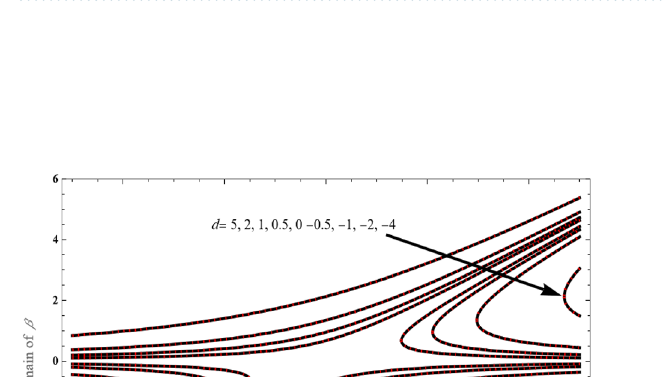
Figure 3. Axial velocity profiles for various values of d , for ( a ) V c > 0 and ( b ) V c < 0 .